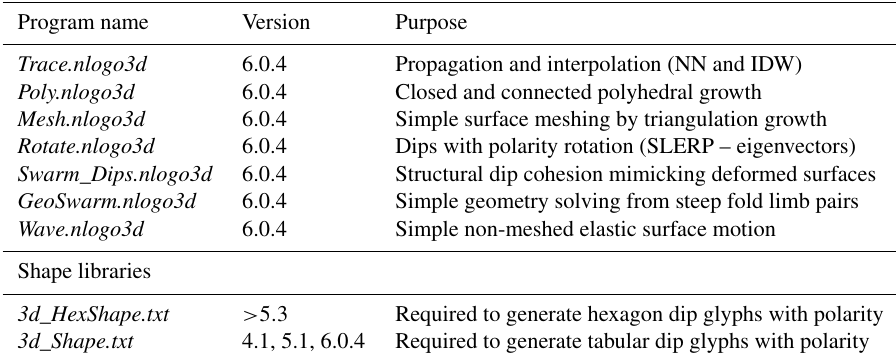
Table B1. Summary of demonstration